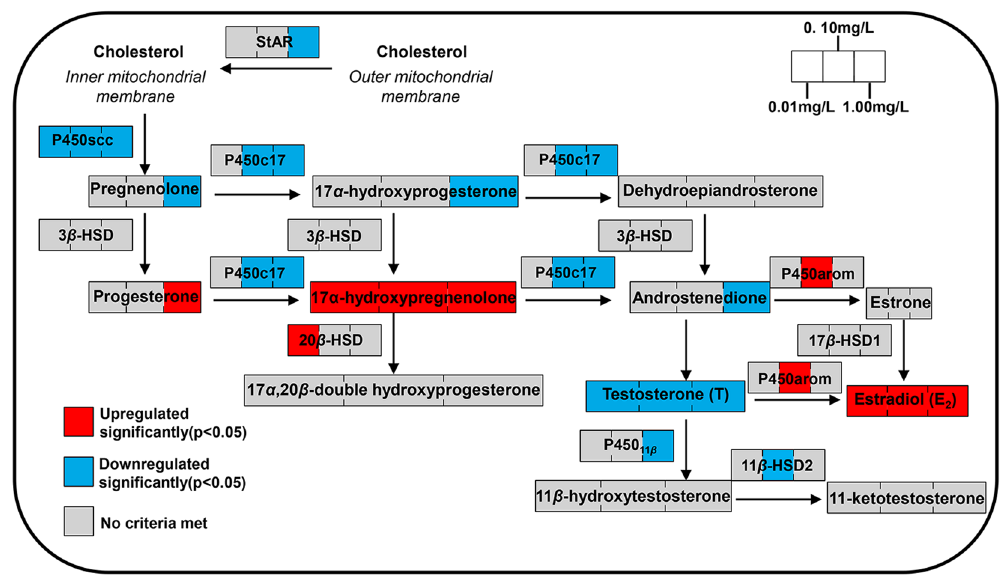
Figure 6. Outline of effects of MCP pesticide on steroidogenesis in male goldfish ( Carassius auratus